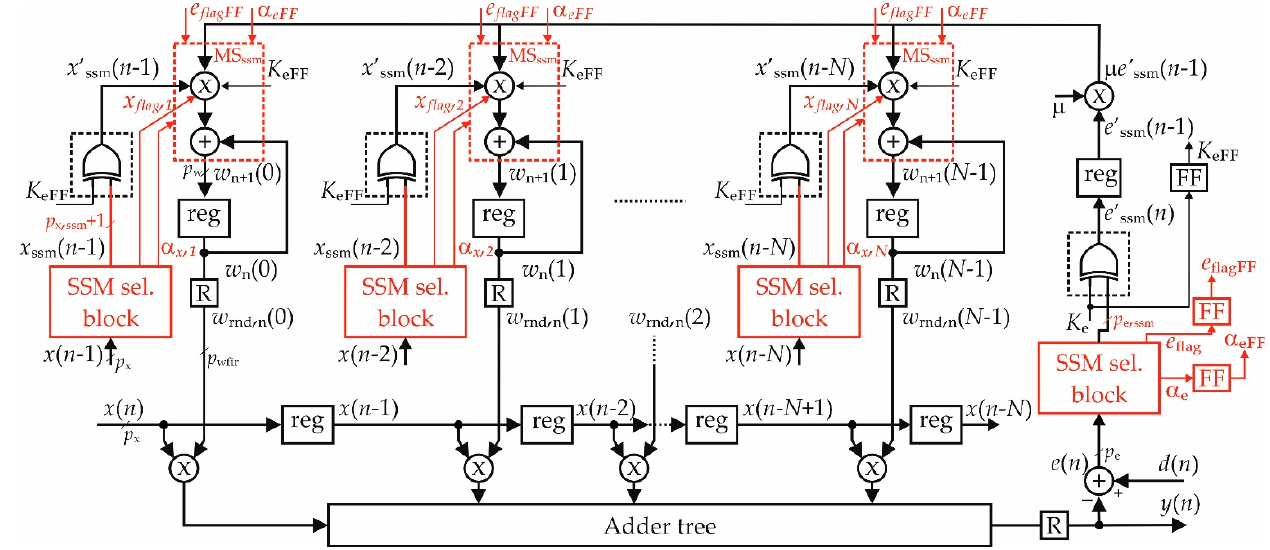
Figure 9. Block diagram of the DLMS filter with static segmented MAC blocks in the learning sec- tion.